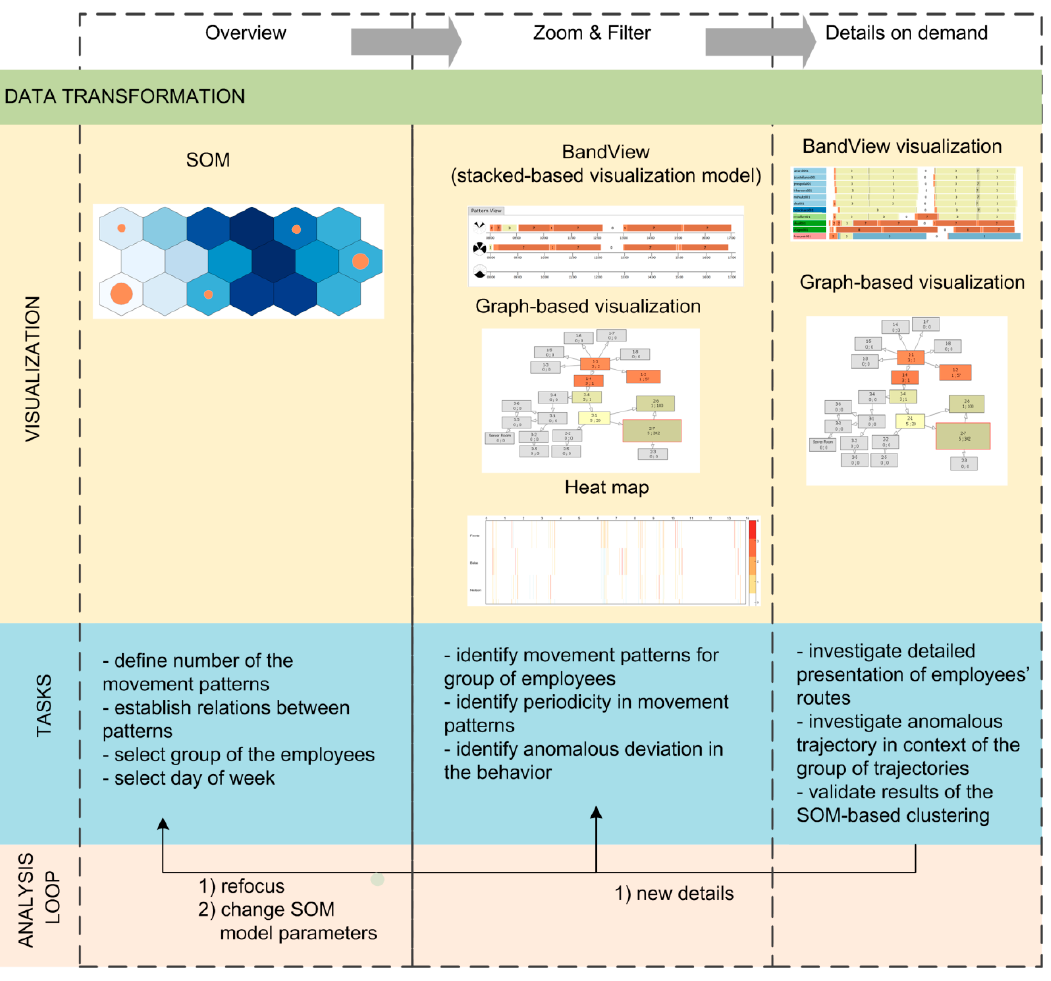
Figure 1. Scheme of the proposed visual analysis process. Energies 2020 , 13 , x FOR PEER REVIEW